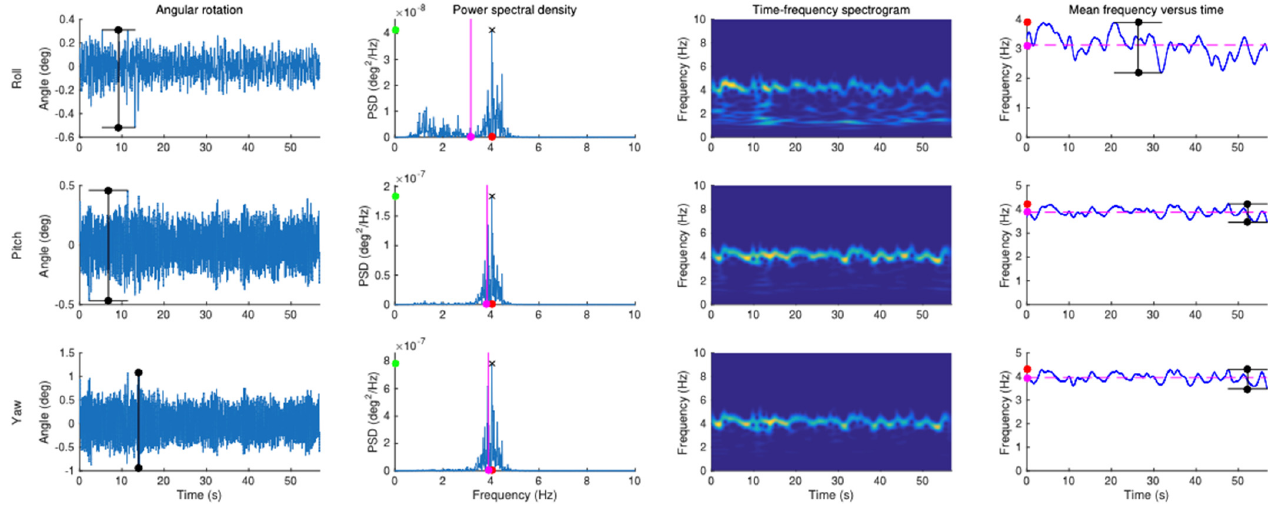
Figure 2. Typical recordings and illustrations of data processing and examples for the angular anal- ysis of head tremor obtained from the IMMU data for forward–backward bending (roll, around x axis), left–right rotation (pitch, around y axis), and lateral bending (yaw, around z axis) in the sitting condition. On each angular rotation plot, the line between black dots represents the angular range of head tremor. On each power spectral density plot, the pink dot corresponds to the mean head tremor frequency, while the red and green dots represent respectively the value and the peak power of the dominant frequency of head tremor identified by a cross. On each plot of mean frequency vs. time, the line between black dots represents the range of head tremor frequency, while the pink and red dots represent respectively the average mean frequency and maximum head tremor frequency. Table 1. List of the dependent variables used in the study after data transformation.